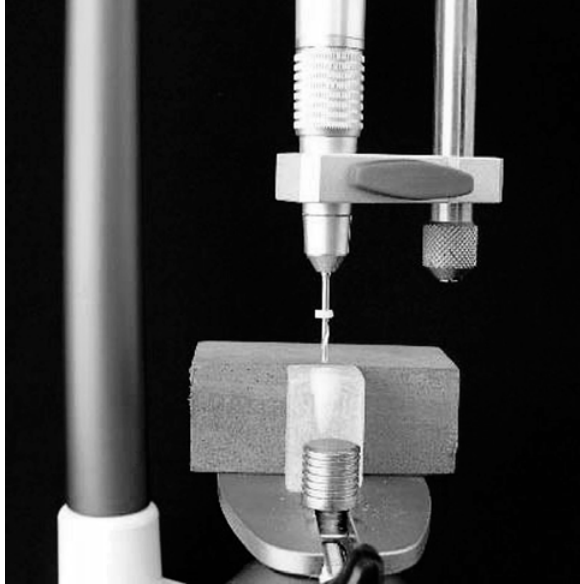
FIGURE 1- Low-speed handpiece coupled to a surveyor for post space preparation